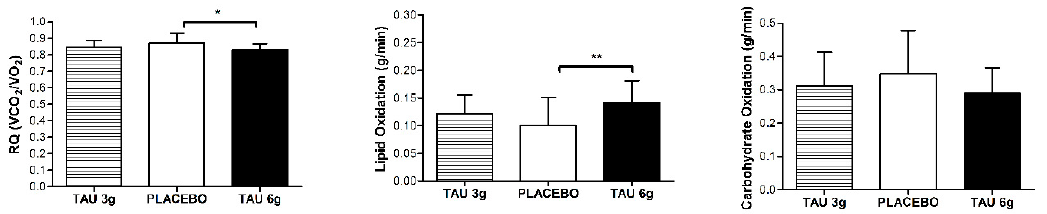
Figure 2. Substrate oxidation after the exercise session. RQ: Respiratory quotient; TAU 3 g: 3 g of taurine supplementation; TAU 6 g: 6 g of taurine supplementation. Symbol represents statistical di ff erence (* p < 0.05, ** p < 0.01) by ANOVA one-way repeated measures.